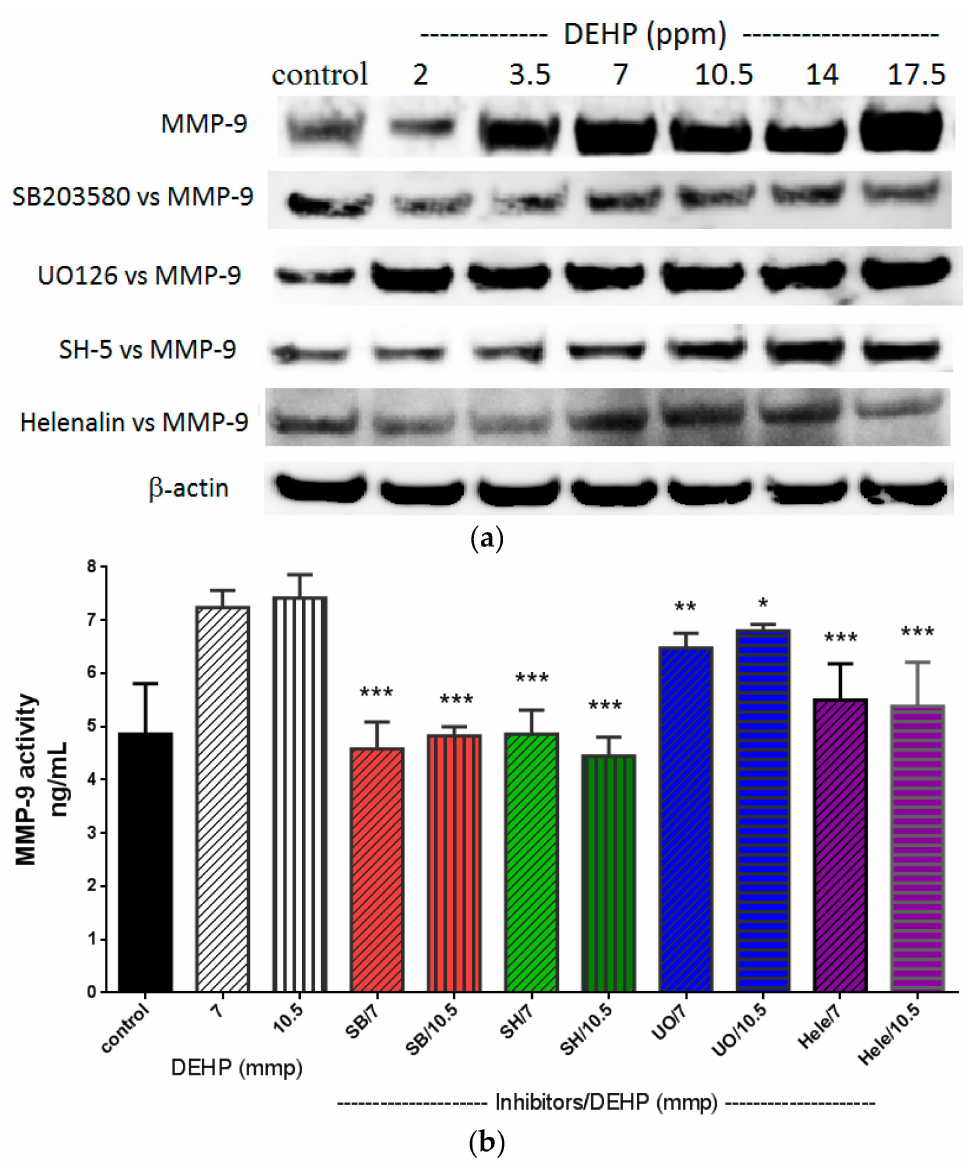
Figure 5. ( a ) Effects of p38 MAPK, ERK1/2, Akt, and NF- κ B inhibitors on DEHP-induced MMP-9 expression. VSMC ( n ě 3) were pre-treated with SB203580 (10 µ M), UO126 (10 µ M), SH-5 (10 µ M), and Helenalin (10 µ M) for 2 h, DEHP (between 2 and 17.5 ppm) was then added and incubated for further 24 h prior to protein extraction. MMP-9 was expressed by Western blotting; and ( b ) effects of p38 MAPK, ERK1/2, Akt, and NF- κ B inhibitors on DEHP-induced MMP-9 activity. VSMC ( n ě 3) were pre-treated with SB203580 (10 µ M), UO126 (10 µ M), SH-5 (10 µ M), and Helenalin (10 µ M) for 2 h, DEHP (7 or 10.5 ppm) was then added and incubated for further 24 h prior to MMP-9 activities being measured. Statistics are shown for SB203580-, SH-5-, and Helenalin-treated cells *** p < 0.005, compared to the DEHP-treated group; for UO126-treated cells (UO/7); ** p < 0.01, compared to the 7 ppm of DEHP-treated group; and for UO126-treated cells (UO/10.5); * p < 0.01, compared to the 10.5 ppm of DEHP-treated